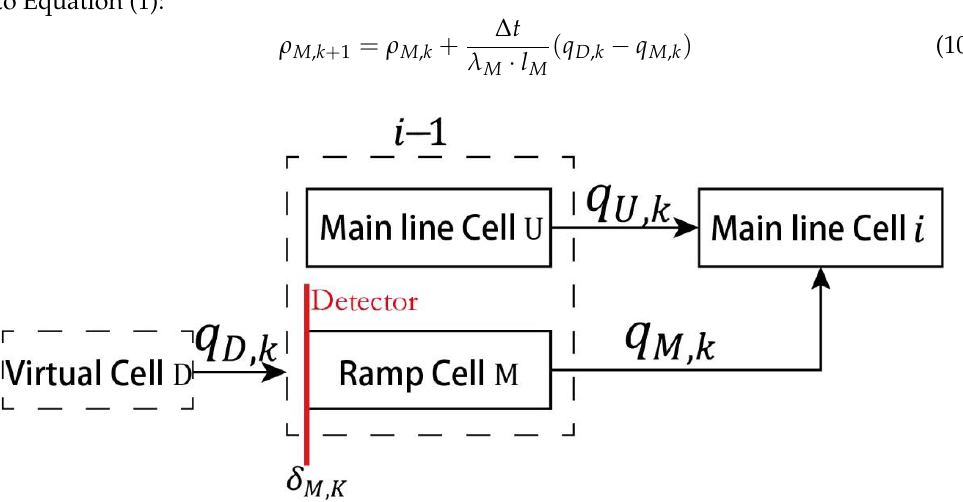
Figure 3. CTM merging segment improved by merging